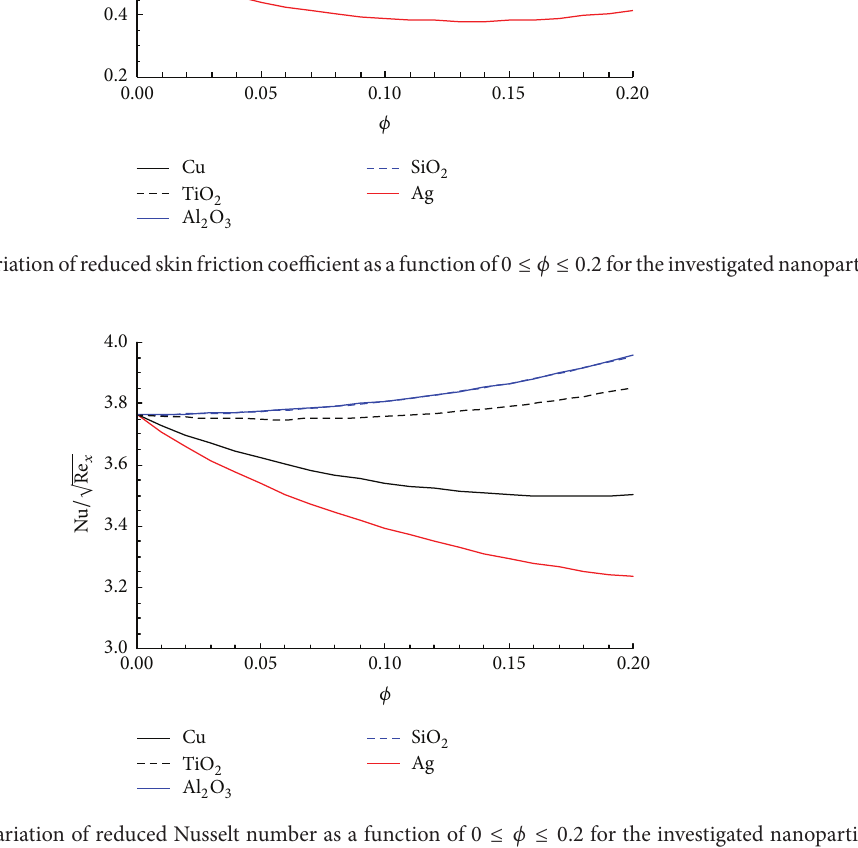
Figure 19: Comparing the variation of reduced Nusselt number as a function of 0 ≤ 𝜙 ≤ 0.2 for the investigated nanoparticles 𝑃𝑟 = 6.2 , = 1 , 𝛿 = −1 , and 𝑠 = 0.5 𝛿 1 2